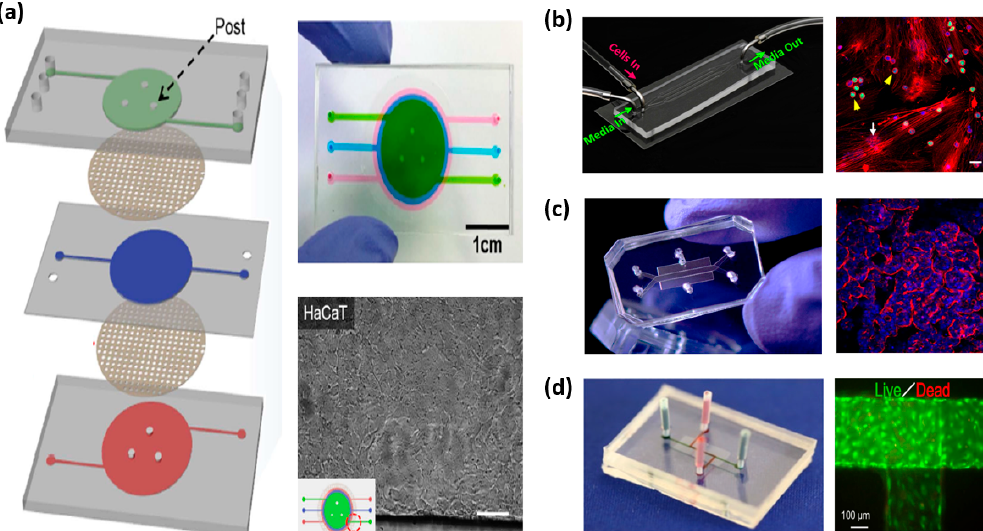
Figure 2. Examples of immune organs-on chip. ( a ) skin-on-chip consisting of three PDMS layers and two porous membranes filled with fluid three different colors or containing HaCaT cells [39], ( b ) bone marrow-on-chip consisting of 4 microchannels and containing SUP-B15 and bone marrow derived stem cell co-culture [40], ( c ) gut-on-chip consisting of two hollow microchannels separated by a porous membrane containing villus epithelium [41] and ( d ) lymphatic vessel-on-chip with a specific microchannel pattern containing blood vascular endothelial cells and lymphatic endothelial cells [42].